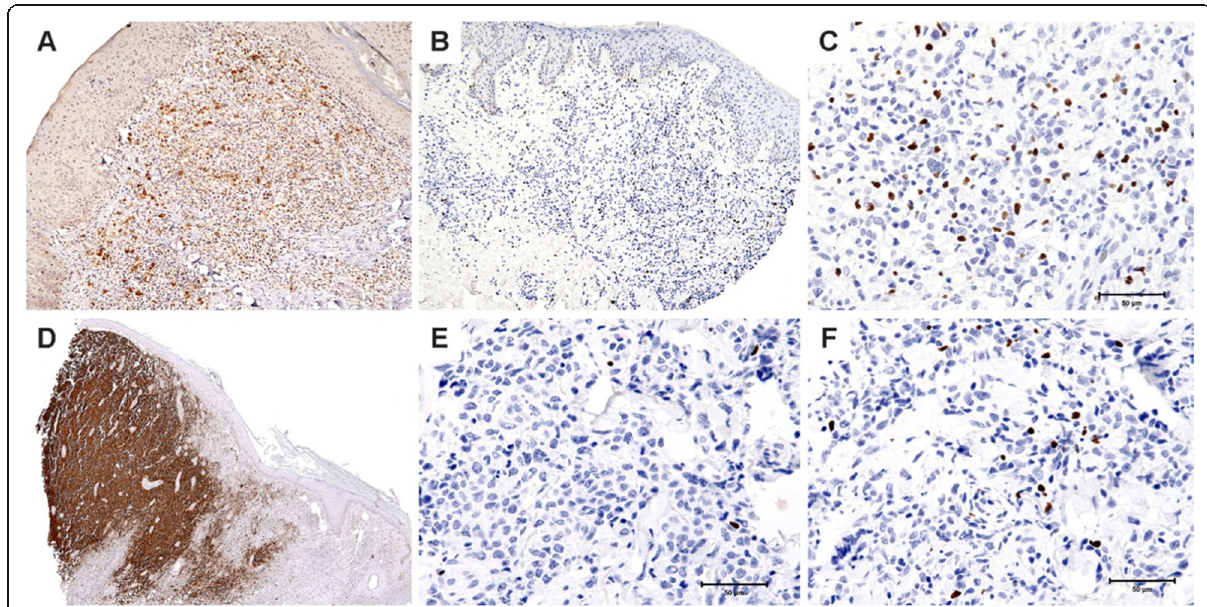
Fig. 1 FOXP3 density in lymphomatoid papulomatosis (LyP) and primary cutaneous anaplastic large cell lymphoma (pcALCL): a - LyP showing few CD30 positive neoplastic cells (100X). b - FOXP3 positive cells distribution throughout LyP lesion (100X). c - The distribution of FOXP3 positive cells was enriched in the center of LyP (400X). d - pcALCL showing diffuse positivity for CD30 (100X). e - Presence of scattered FOXP3 positive cells in the center of pcALCL (400X). f - The distribution of FOXP3 positive cells was enriched in the edge of pcALCL (400X)